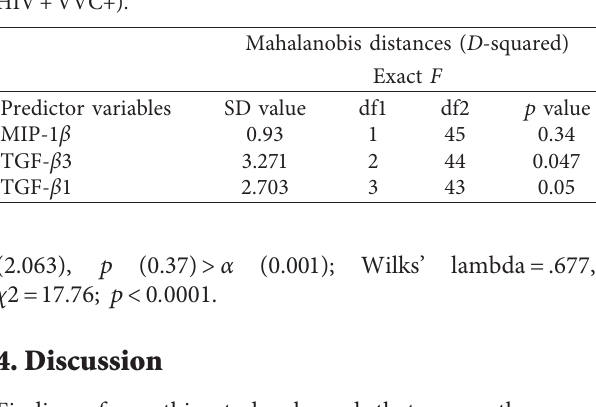
Figure 2: Canonical discriminant functions displaying centroid groups: 4 study groups (HIV − VVC − ; HIV − VVC+; HIV+VVC; and HIV+ VVC+) discriminated by 2 CDA functions made of 3 significant variates (MIP-1 β , TGF- β 1, and TGF- β 3) which con- tributed 99.5% of the total variance. Table 4: Predictor variables displaying maximum Mahalanobis distances between the two closest groups (HIV − VVC+ and HIV+